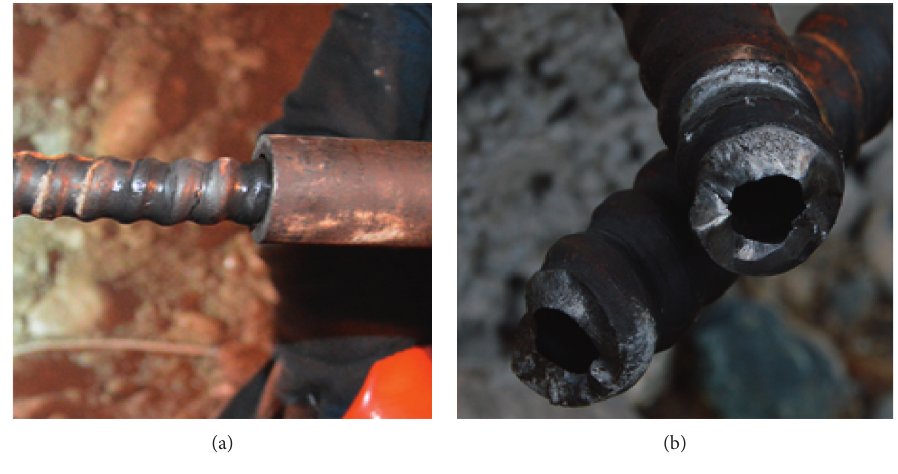
Figure 8: Torsional failure patterns of bolt